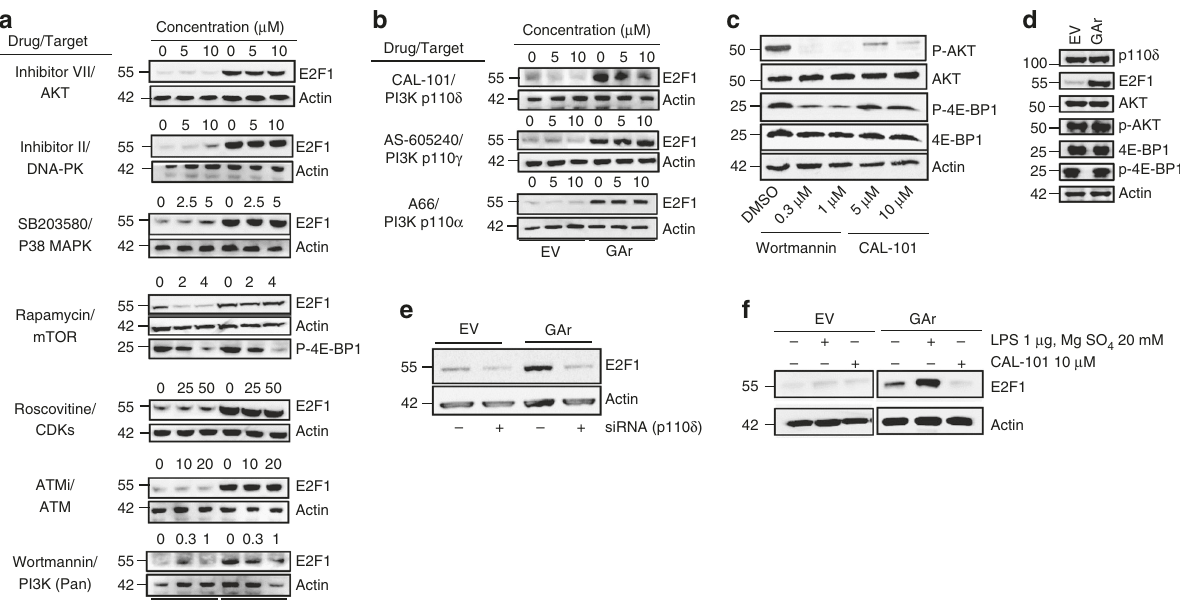
Fig. 5 GAr-dependent induction of E2F1 is mediated via PI3K δ . a Western blots show the expression of E2F1 in H1299 cells expressing the GAr or EV following treatment with indicated drugs for 8 h. Phosphorylated 4E-BP1 (P-4E-BP1) was used to show mTOR activity. b Western blots show E2F1 expression levels in cells expressing the GAr or control plasmid (EV), treated with the indicated concentrations of inhibitors of PI3K p110 δ (CAL-101), p110 γ (middle panel) and p110 α (lower panel) subunits. c The effect of wortmannin and the PI3K δ -speci fi c inhibitor (CAL-101) on the phosphorylation of AKT (P- AKT) and 4E-BP1 (P-4E-BP1) in cells treated with 40 ng/ml of PDGF for 30 min in serum-free medium. d Western blots showing the effect of GAr on the phosphorylation of AKT and 4E-BP1. e Western blot showing the expression of E2F1 following 24 h treatment with siRNA against PI3K δ . f Western blot showing the expression of E2F1 in cells expressing EV or GAr followed by general induction of PI3K activity using MgSO 4 (20 mM) and LPS (1 µ g), with, or without, CAL-101 (10 µ M). Western blots represent n ≥ 3. Actin was used as a loading